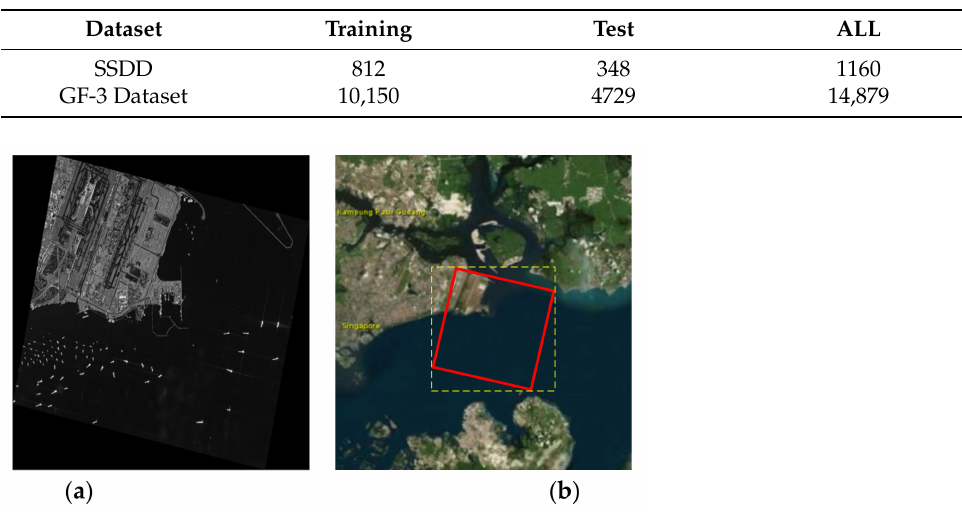
Figure 7. The large-scene images. ( a ) GF-3 HR SAR image. ( b ) Corresponding optical image.